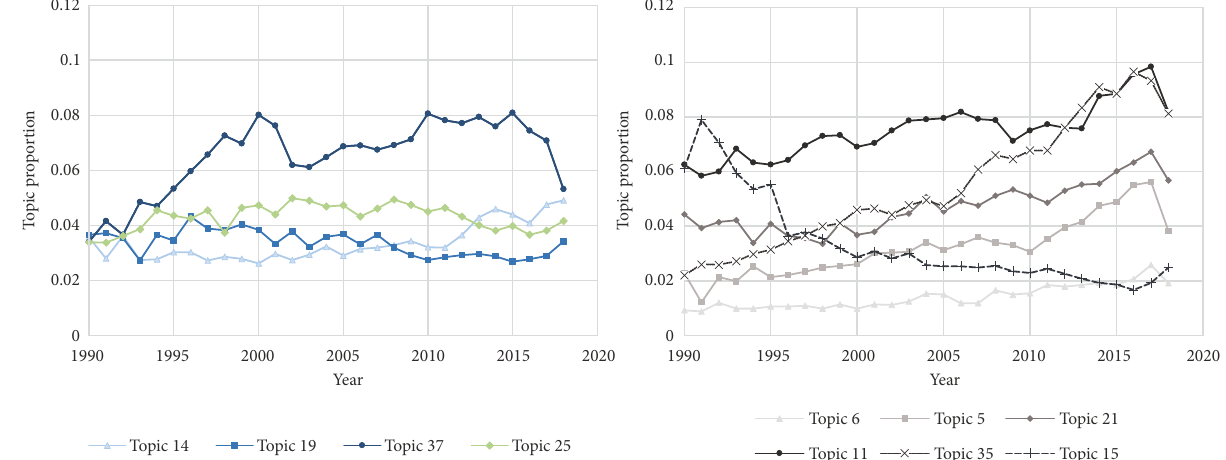
Figure 6. Proportion trends of ten competence related